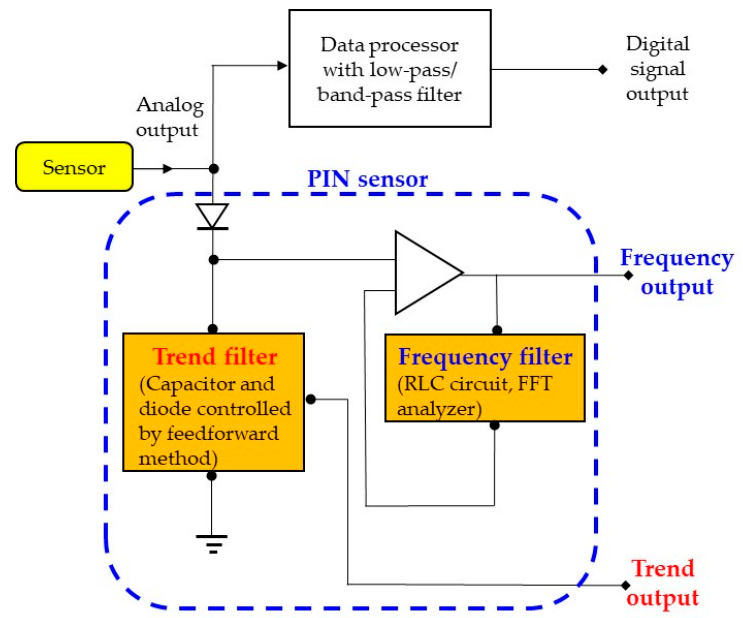
Figure 2. The PIN sensor design for increasing the prediction accuracy based on the conditional probability and Bayes’ theorem.